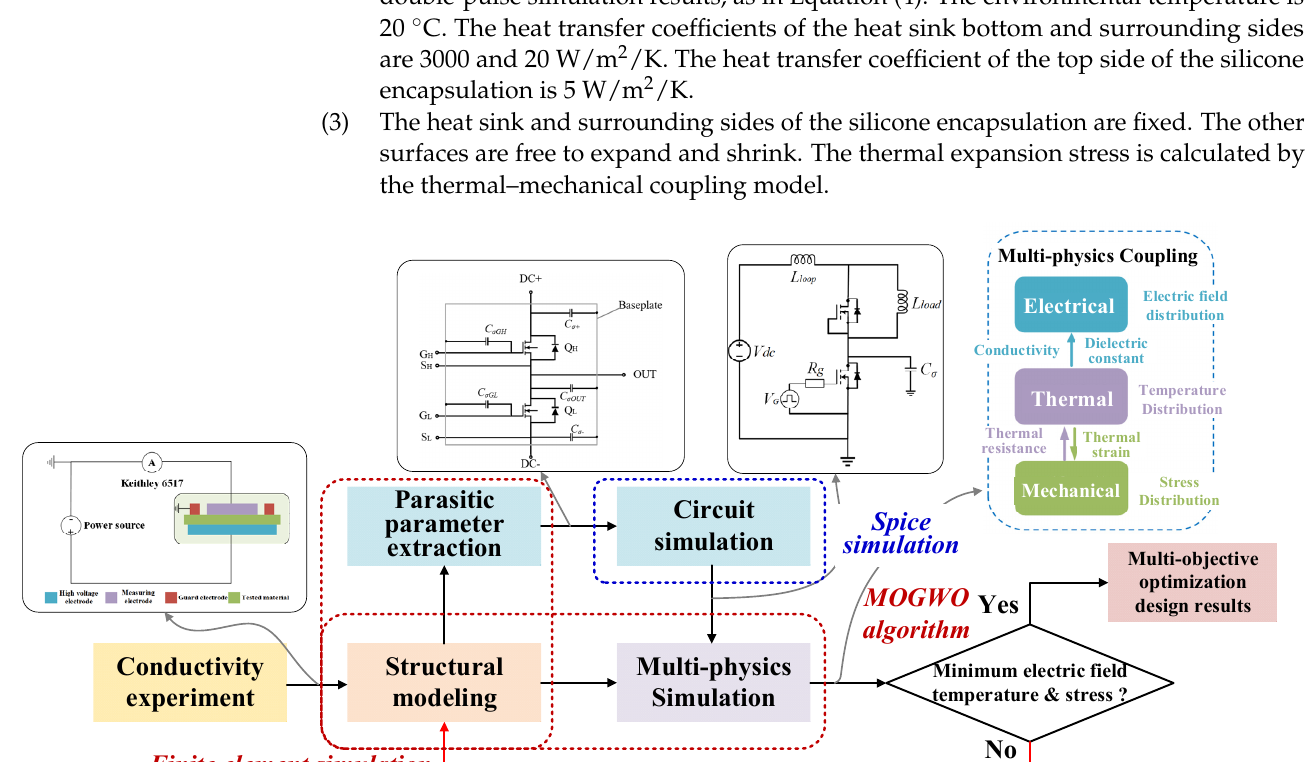
Figure 6. The flow chart of multi-physics coupling